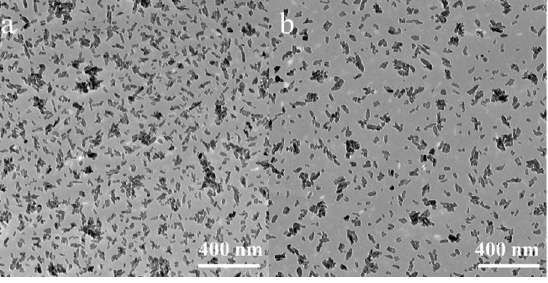
Figure 1. TEM micrographs of SPEX-milled Hydroxyapatite (HA) ( a ) and manganese-substituted hydroxyapatite (MnHA) ( b ) powders.